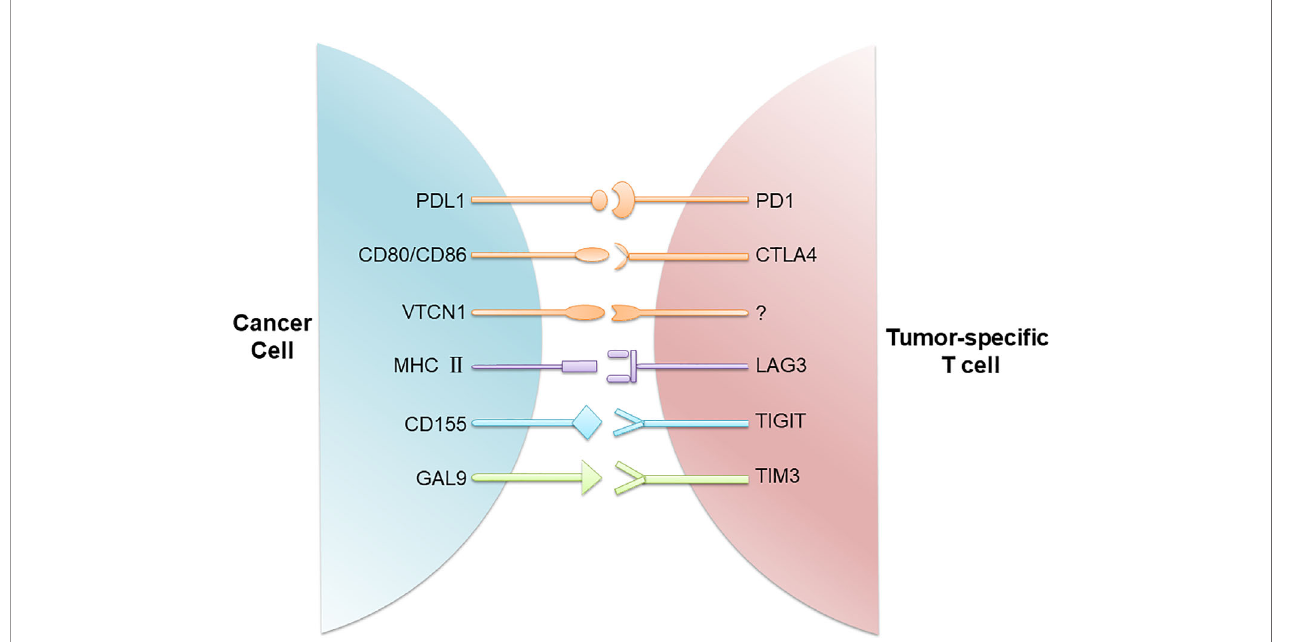
FIGURE 1 | Immune checkpoints involved in T cell inactivation. Cancer cells evade the host immune system through upregulation of immune checkpoints composed of the ligands on the cancer cell and the respective receptors on the CD8 + T cell. These ligand/receptor pairs include PDL1/PD1, CD80/CD86/CTLA4, MHC II/LAG3, CD155/TIGIT, and GAL9/TIM3. In addition, VTCN1 is also found on TNBC cells, although its receptor on T cells is not